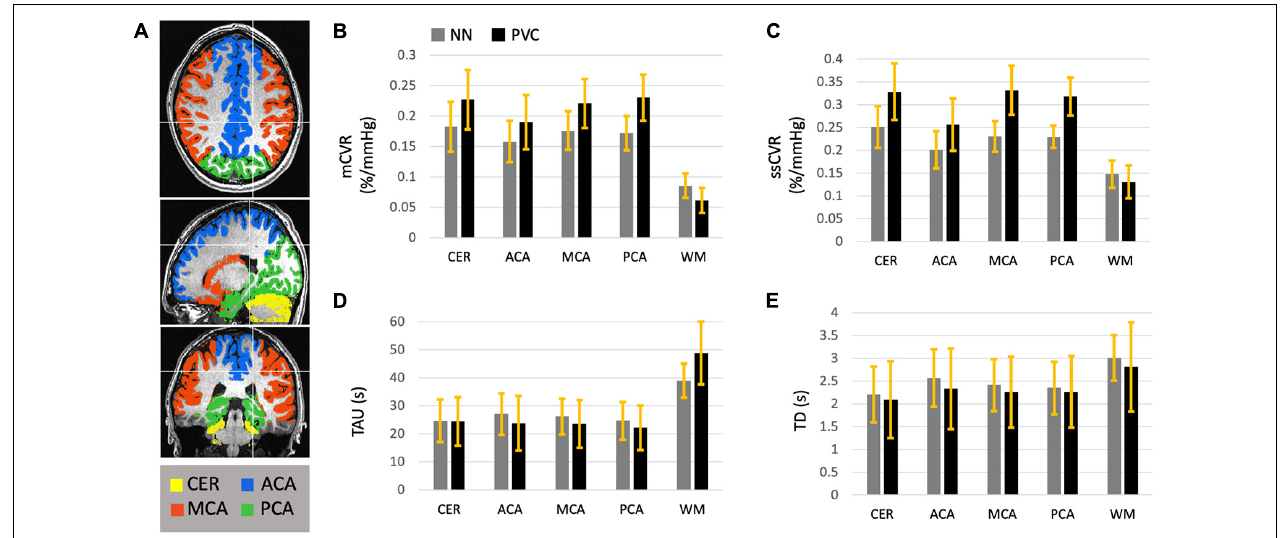
FIGURE 4 | This diagram represents the average mCVR (B) , ssCVR (C) , TAU (D) , and TD (E) over five gray matter ROIs and over 45 normal controls. The ROIs (A) consist of gray matter in the cerebellum (CER), the anterior (ACA), middle (MCA), and posterior (PCA) cerebral artery territories, as well as all hemispheric white matter (WM). This diagram shows the results after CVR metrics maps were resampled to the high resolution anatomical scan using nearest neighbor (NN, in gray), as well as corrected for partial volume effect (PVC in black). The standard deviations are represented with the yellow